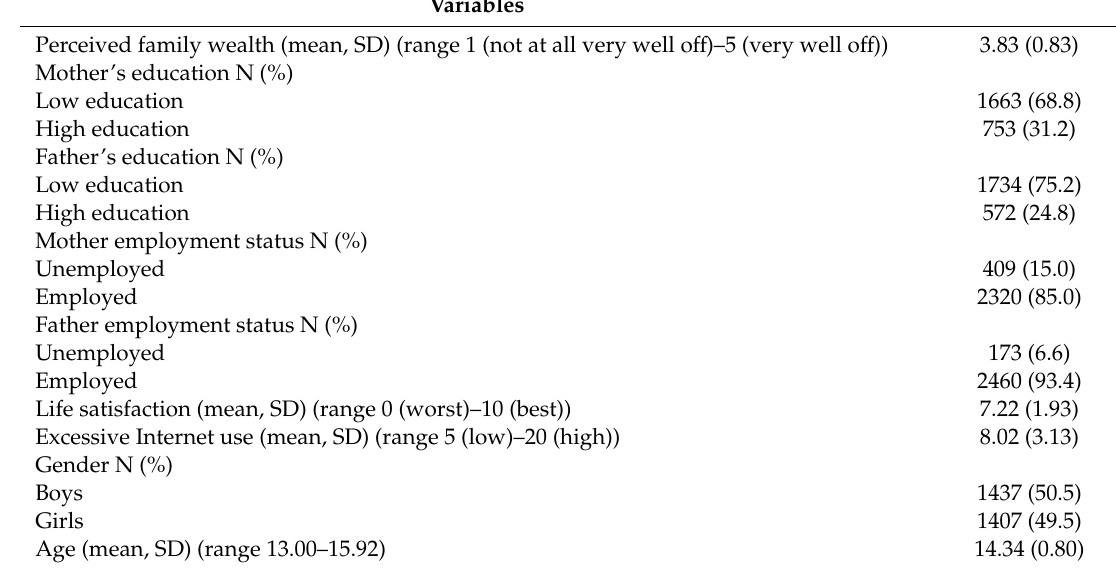
Table 1. Background characteristics of the sample (2844 Slovak adolescents aged 13–15 years old, HBSC study